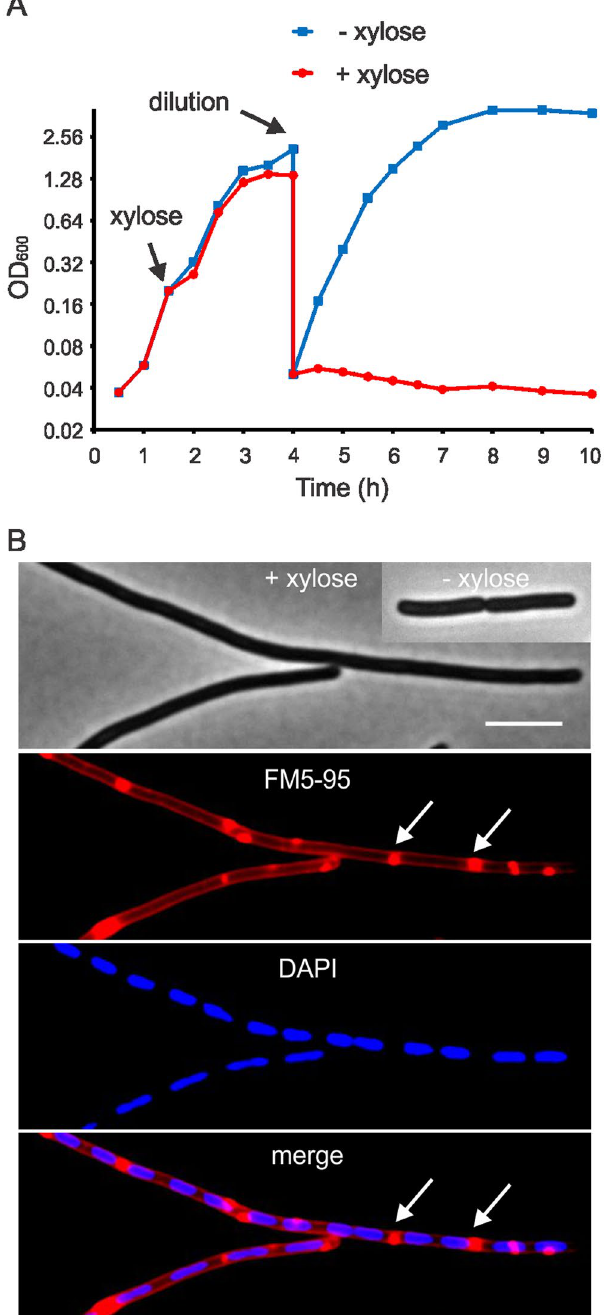
Figure 1. SepF overexpression in B. subtilis . ( A ) Growth curve of B. subtilis strain GYQ215 containing an extra xylose-inducible sepF gene ( amyE ::P xyl-sepF ) grown with or without 1% xylose. After 3 h induction, cultures were diluted into fresh medium. ( B ) Fluorescence light microscopy images of cells after 3 h induction. Membrane and DNA were stained with FM5-95 and DAPI, respectively. Membrane invaginations are indicated by arrows. Scale bar is 5 µ m. More images of membrane stained SepF-overexpressing cells can be found in Fig.